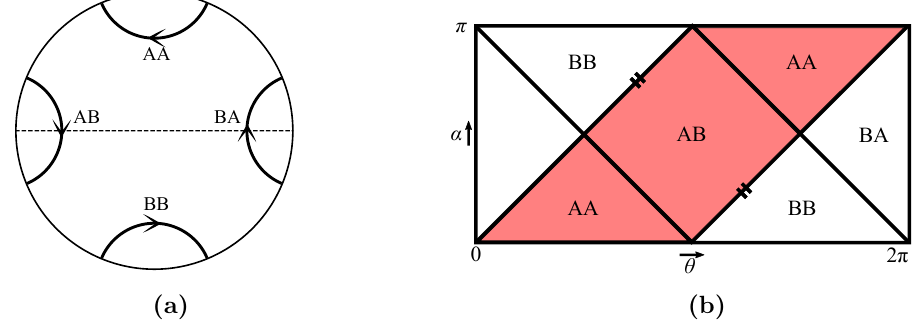
Figure 3 . (a) Oriented geodesics in the Poincar(cid:19)e disk labelled by their endpoint locations. The N = 2 wedges are shown with two identi(cid:12)ed boundaries A and B. (b) Regions of kinematic space labelled by the boundaries each geodesic ends on. For the conical defect with N = 2, the shaded diagonal strip is a fundamental domain equivalent to the vertical